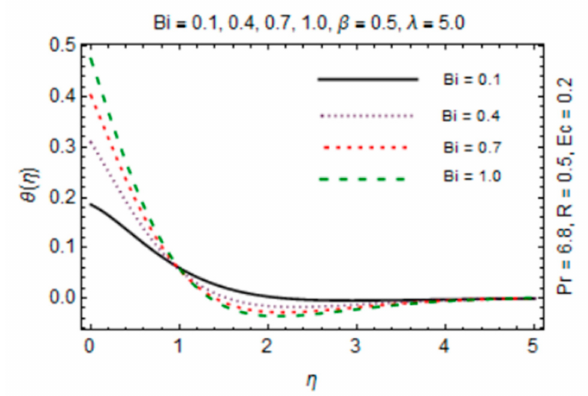
Figure 13. Bi verses temperature profile.